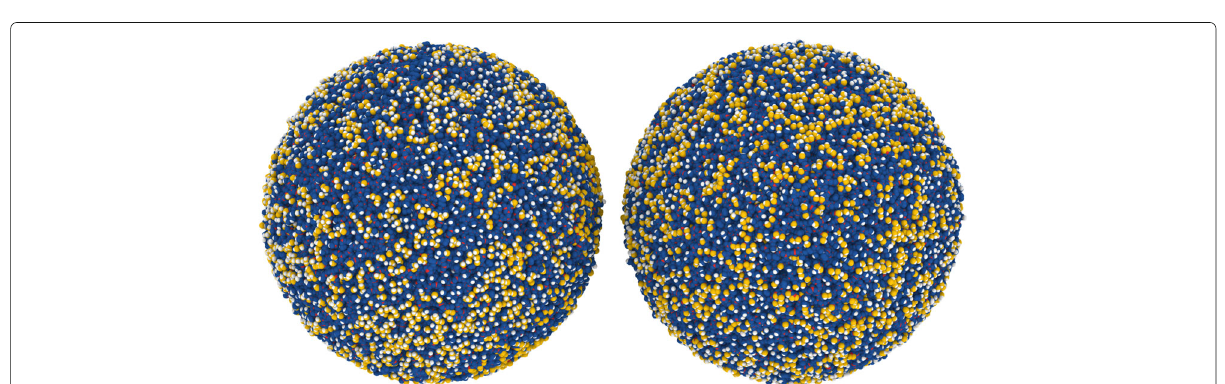
Fig. 1 Hydroxylated silica NPs. Hydroxylated silica NPs of radius R = 10 nm immediately before collision. Red, Si; blue, O bonded to Si; orange, O in an OH group; white,